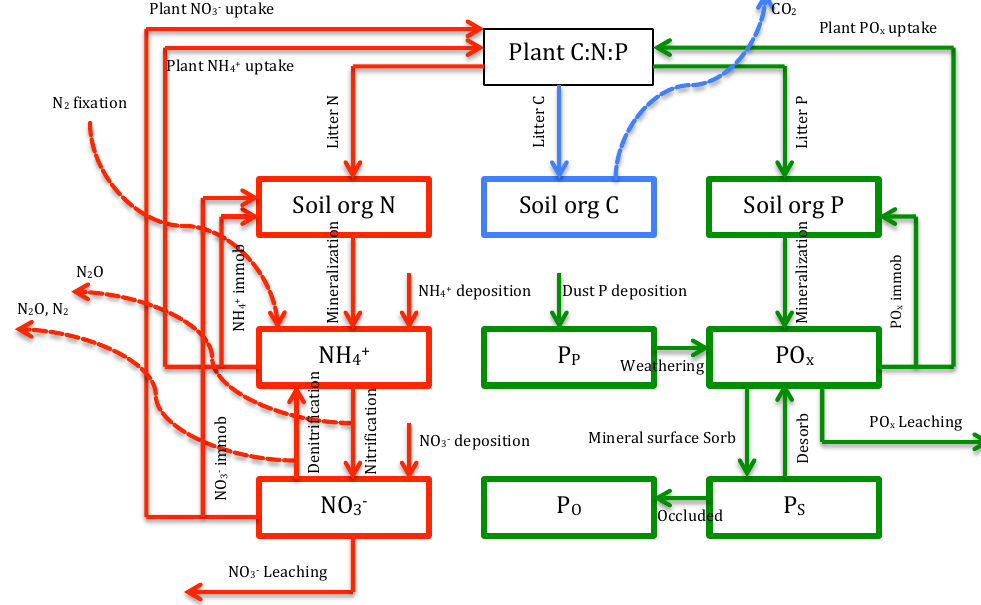
Figure 1. Model structure. Boxes represent pools, solid arrows represent aqueous fluxes and dashed arrows represent gaseous pathways out or into the system. Three essential chemical elements (carbon, C; nitrogen, N; and phosphorus, P) are simulated in N-COM (blue, red and green represent C, N and P pools and processes,